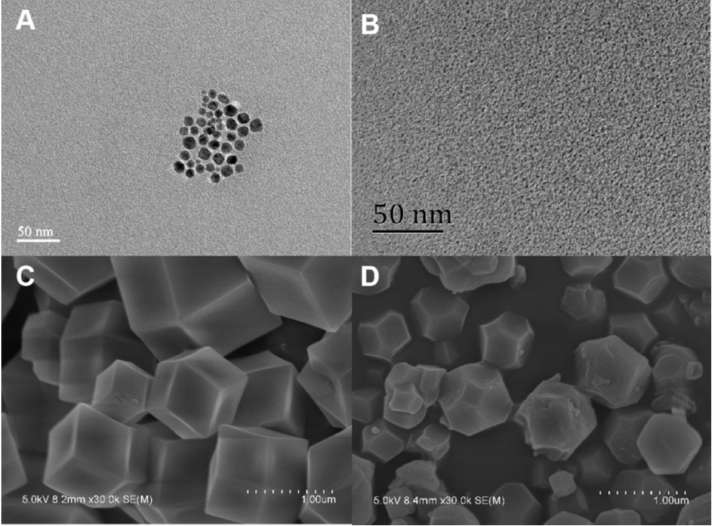
Figure 3. ( A ) TEM image of CdSe/ZnS QDs; ( B ) TEM image of CQDs; ( C ) SEM image of pure ZIF-67; ( D ) SEM image of the CQDs/QDs@ZIF-67